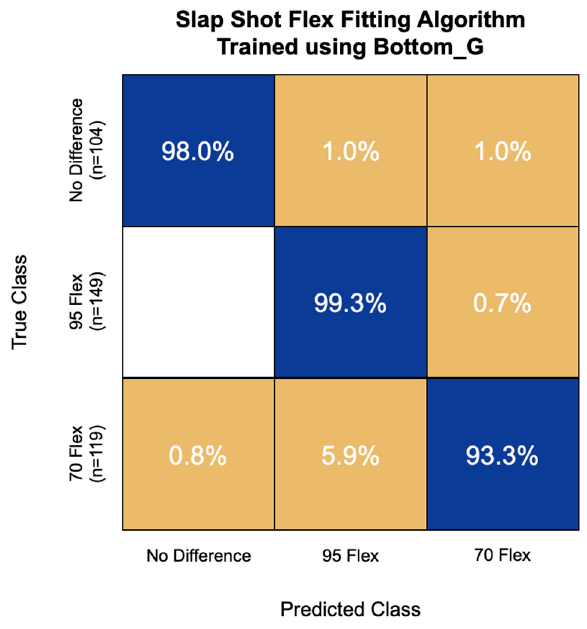
Figure 6. Confusion matrix of the flex fitting algorithm for slap shot speed trained using bottom hand resultant angular velocity (Bottom_G) signal features. Overall model accuracy was 97.3%.